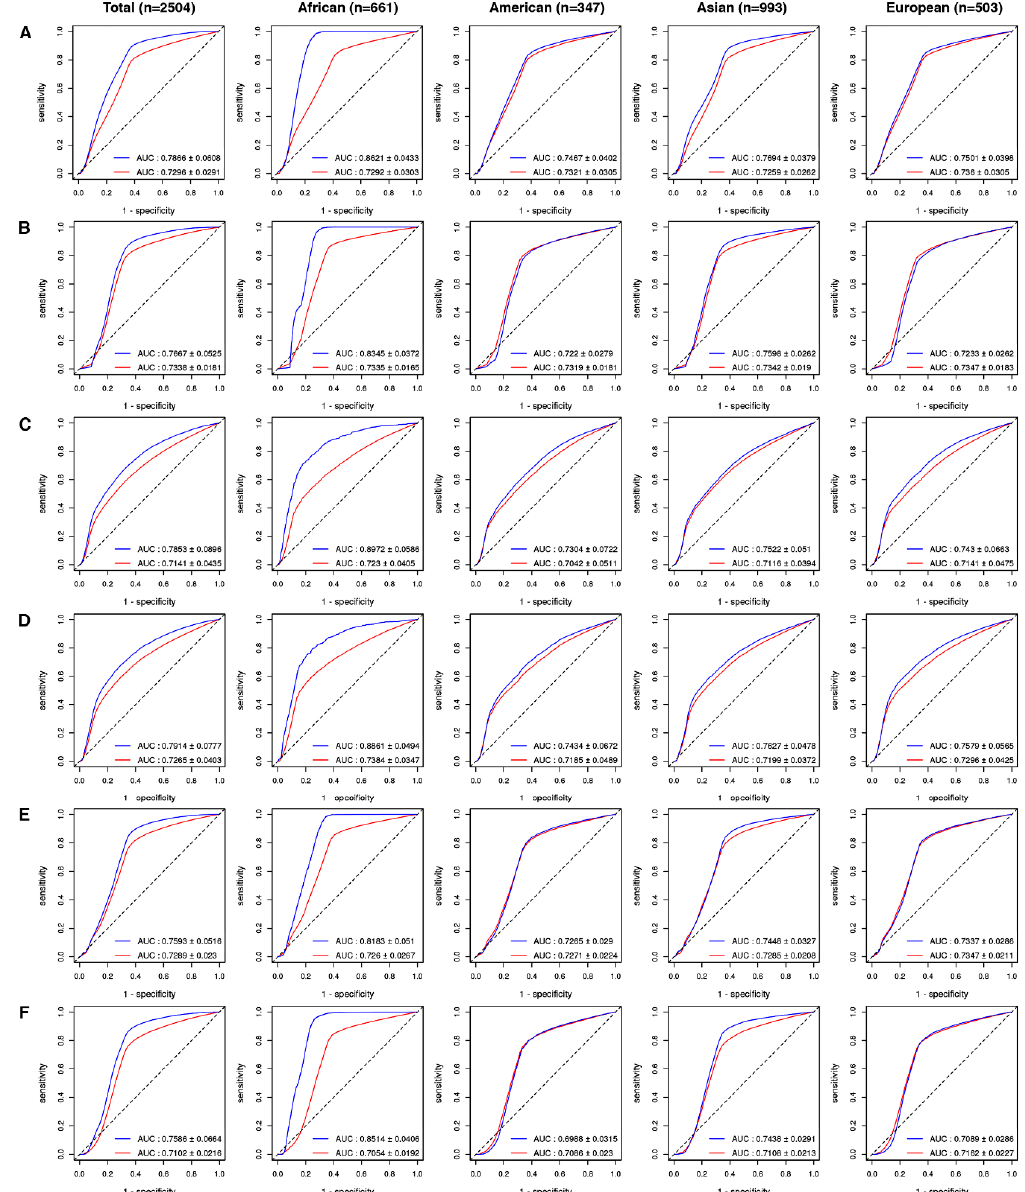
Figure 3. Ethnicity-specific and non-specific GVB evaluations against the variant-drug associations in PharmGKB, the gold standard, for 2504 individual genomes of the 1000 Genome Project. The AUCs (mean ± SD) were obtained from the ethnicity-specific (blue line) and the non-specific (red line) evaluations of the 5099 drugs from the DrugBank using ( A ) SIFT, ( B ) MutationTaster, ( C ) Polyphen-2 HVAR, ( D ) Polyphen-2 HDIV, ( E ) phyloP, and ( F ) GERP ++ for all and four ethnic subgroups, including African ( n = 661), American ( n = 347), Asian ( n = 993), and European ( n = 503). The dotted line represents the reference line (AUC = 0.5). AUC: area under the receiver operating characteristics curve.